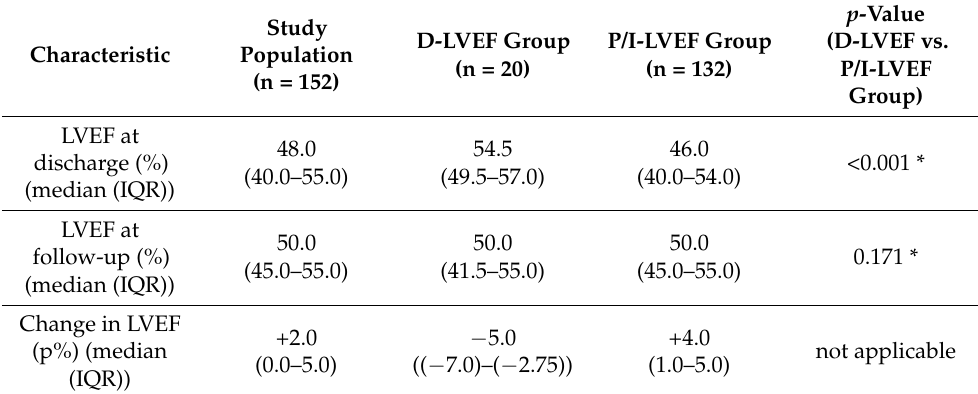
Table 2. Comparing LVEF at the time of discharge, LVEF at follow-up and change in LVEF between the D-LVEF group and P/I-LVEF